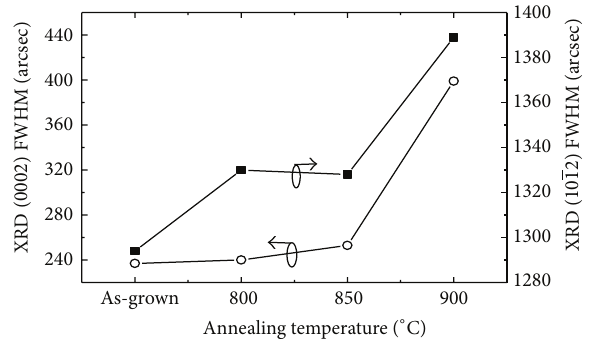
̄1 2) XRD rocking curve at